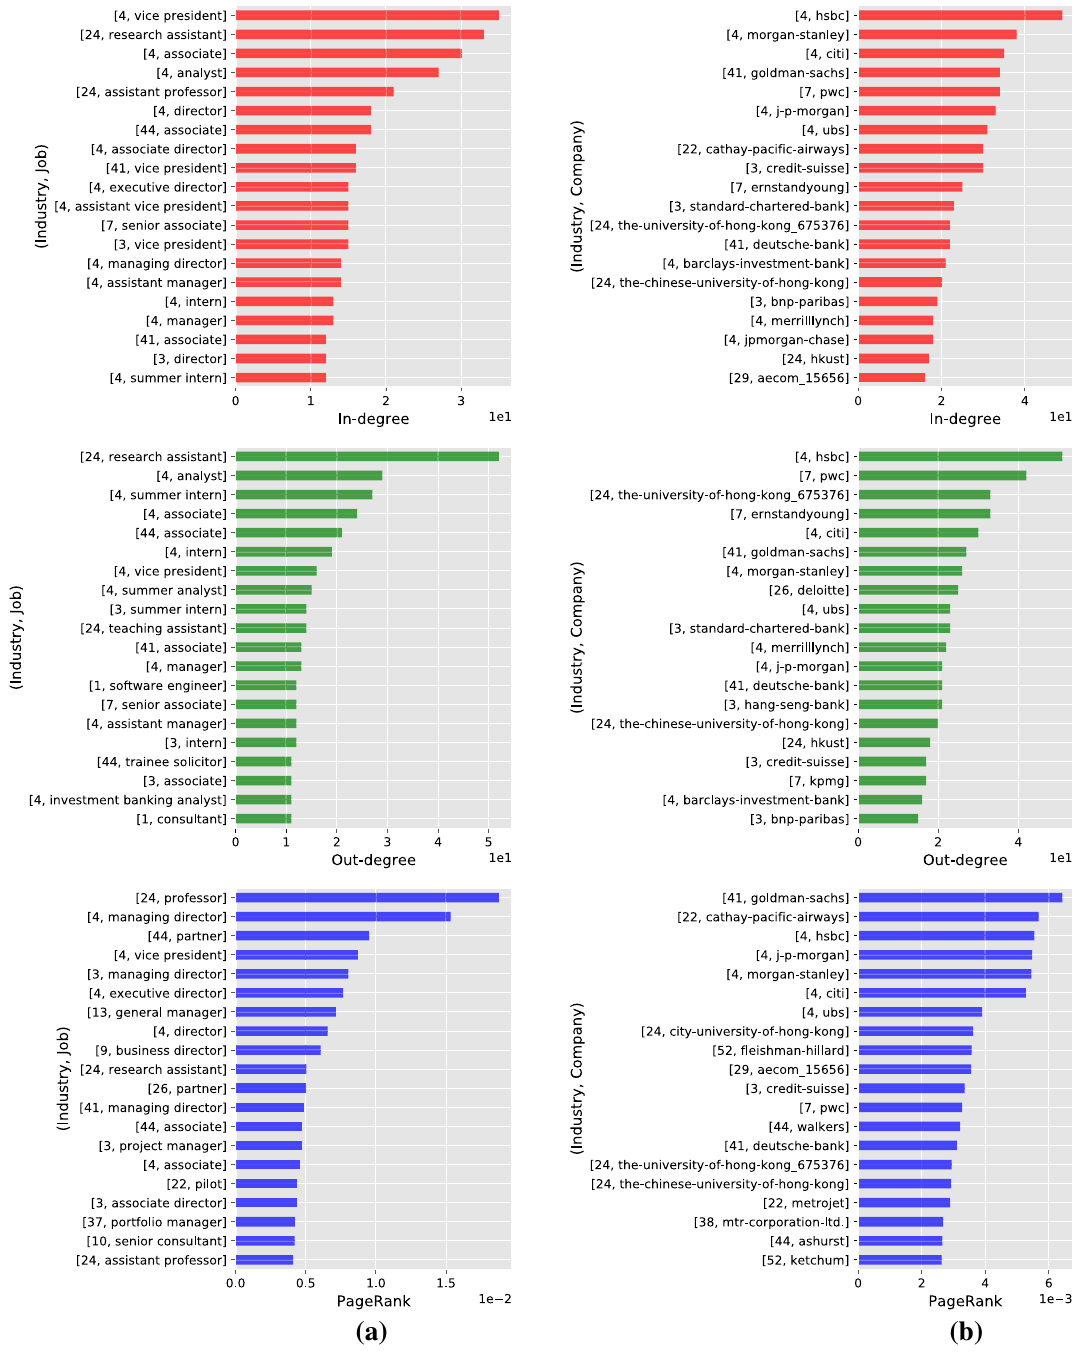
Fig. 16 Centrality of top jobs and companies in Hong Kong. a Top jobs in Hong Kong. b Top companies in Hong